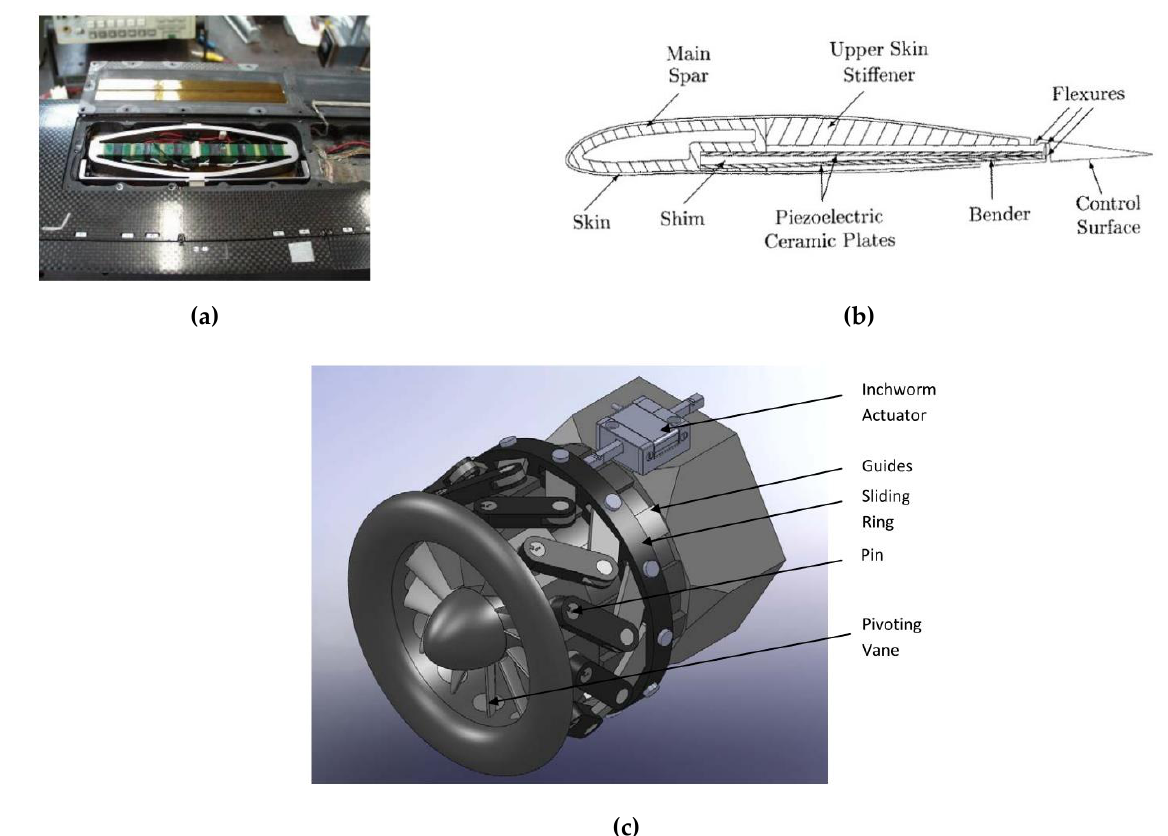
Figure 18. Examples of the piezoelectric system in aerospace applications: ( a ) active flap on a helicopter blade using an amplified-piezoelectric actuator [183]; ( b ) piezoelectric bender for helicopter rotor control (from [100]); ( c ) linear inchworm piezoelectric actuator for application in inlet guide vanes (from [47] ).